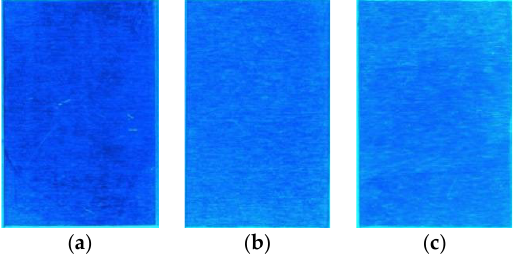
Figure 6. ( a ) Feature image of 1060; ( b ) Feature image of 5052; ( c ) Feature image of 6061.